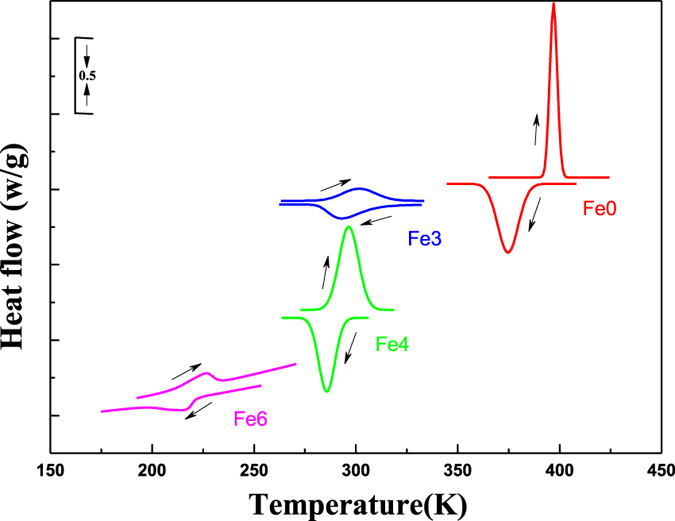
DSC curves of the Ni50−xFexMn39Sn11 alloys.